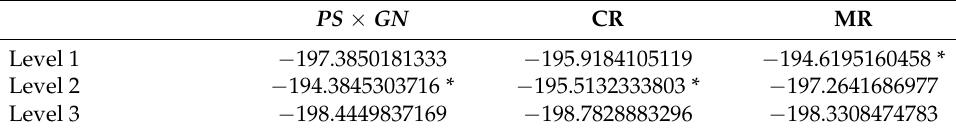
Table 4. Sum of SN